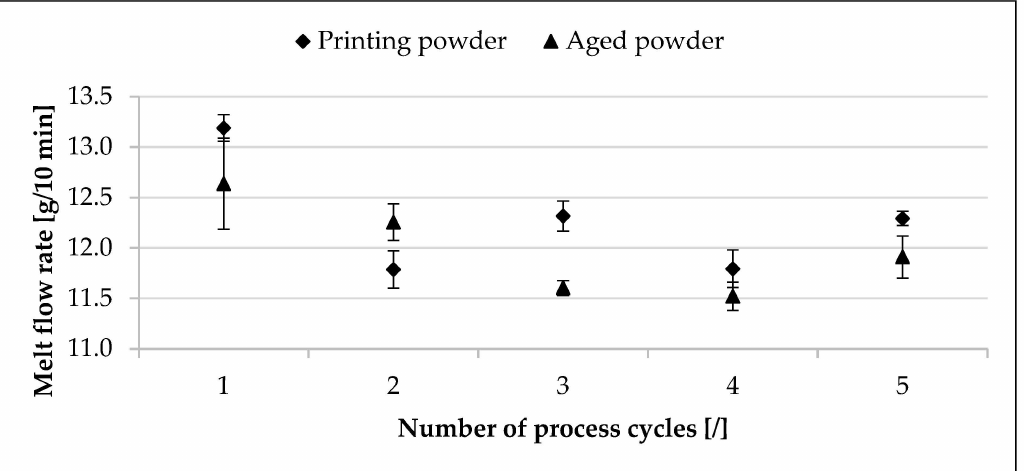
Figure 10. Influence of cyclic reuse on the melt flow rate of the used polyamide 12 sinter material. Five process cycles were considered. The printing powder and the aged powder were analyzed. The refresh rate was 30